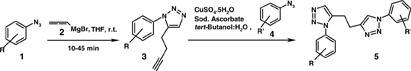
Domino-click method for the synthesis of unsymmetrical bis 1,2,3-Triazoles.